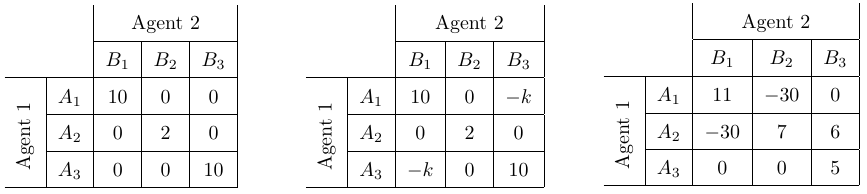
Figure 4. Game matrices with different coordination problems: Attainable, penalty, and climbing as presented by Claus et al.